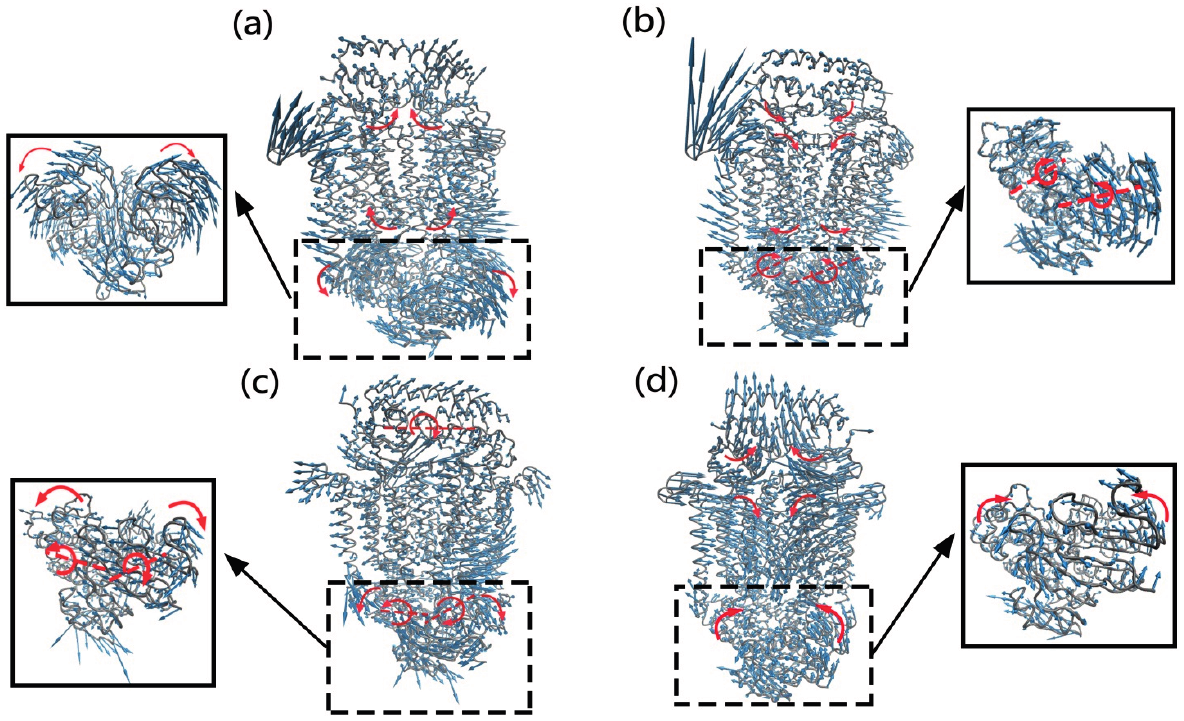
Figure 3. The motions of modes 10 ( a ), 13 ( b ), 25 ( c ) and 26 ( d ), which are relevant to the channel-gating function of the transporter. The close-up views of the NBDs for all the modes are also displayed. In this figure, the structure of the transporter is displayed in gray tube, and the amplitude and direction of the motions are denoted by the length and direction of the blue arrows. The red arrows and dotted lines respectively represent the motion direction and axis of the subdomains of the